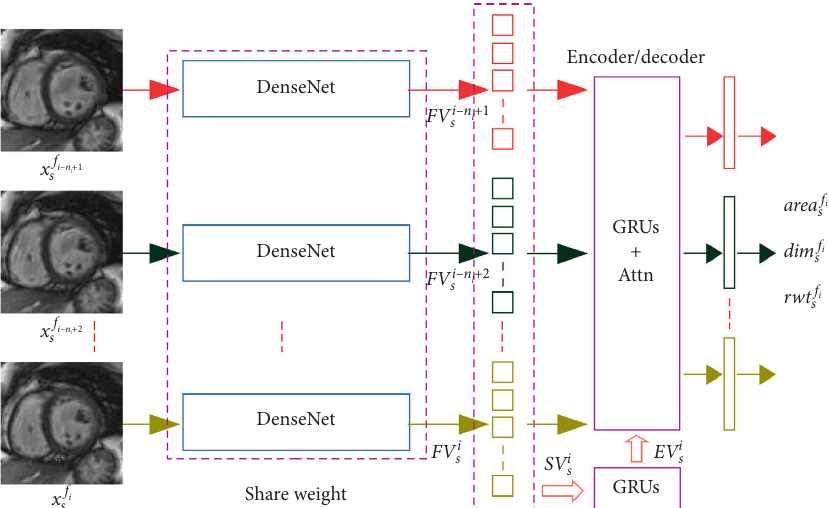
Figure 2: The proposed framework for left ventricle quantification. The GRUs constitute the encoder and the GRUs+ Attn constitute the